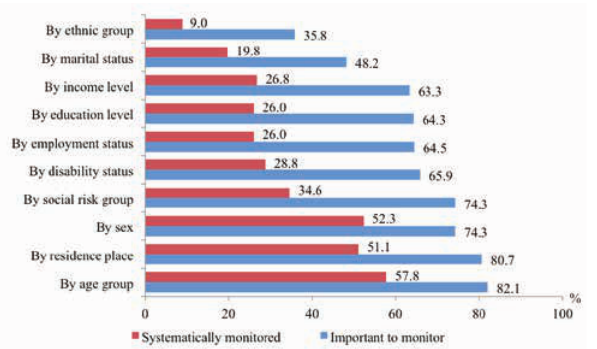
Figure 2: Respondents’ attitudes towards the usage of health